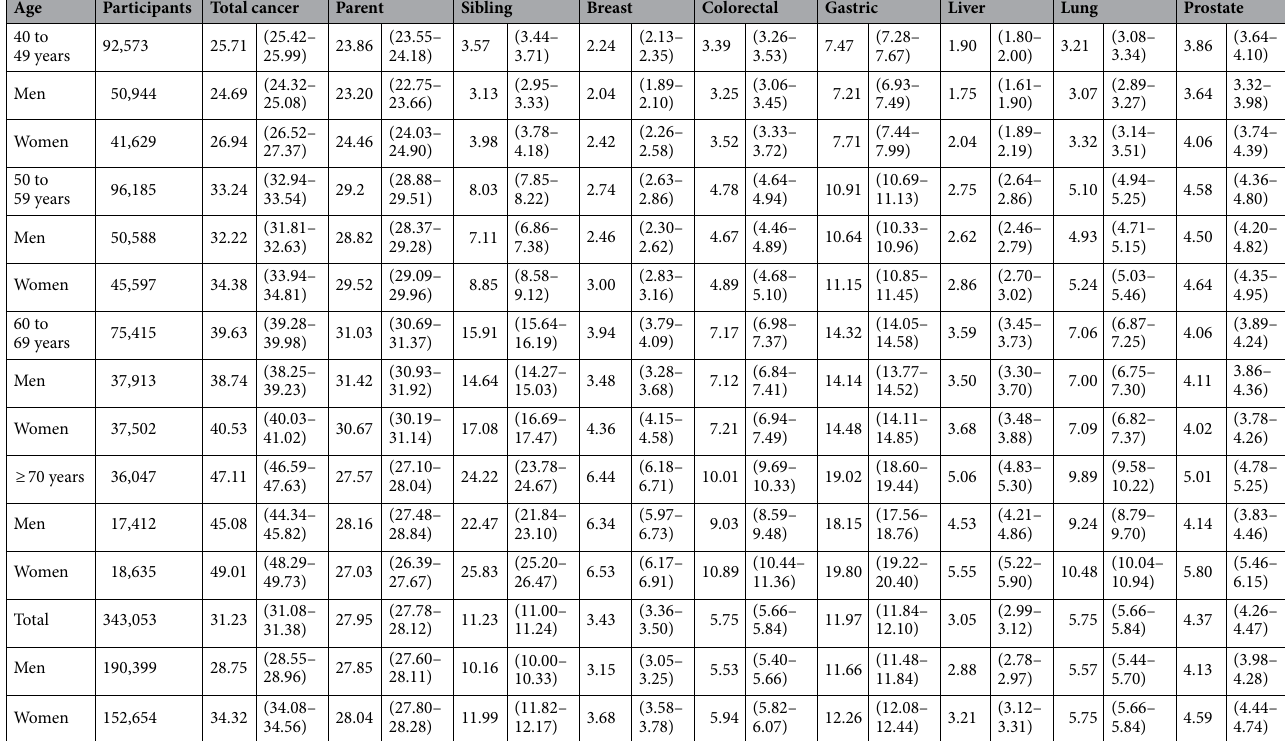
Table 2. Prevelance of family history of cancer and corresponding 95% confidence intervals by age in seven Japanese cohort studies. Participants for family history of total cancer; total includes those < 40 years and missing age; J-ECOH only total cancer; Suita Cohort only total, parent and sibling; Age 15–39 from J-ECOH and Suita: 42,833 participants 10.51% (95% CI: